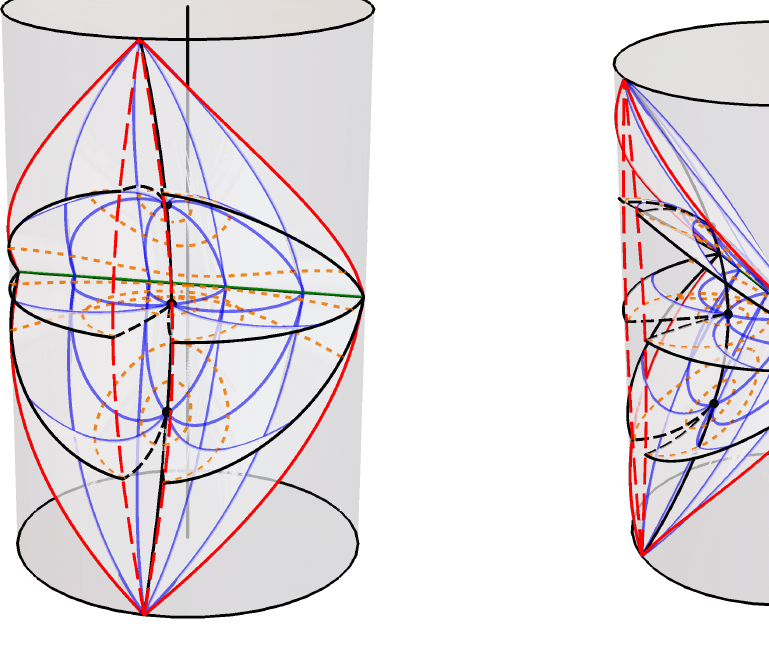
Figure 7 . The Class I rapid,A solution embedded within global AdS 3 . The particle worldline is shown in solid black. Several surfaces of constant t are plotted. The event horizons are demonstrated by the surfaces at early and late t . The bifurcation surface is shown as a green line. A “wedge” is removed, with its edges x = x + and x 0 = x + identified; this is the location of the domain wall. These edges are shown in long-dashed black within each time-slice, and in dashed red at the boundary. The boundary of the classically accessible subset of the global boundary is shown in red. Lines of constant x are shown in blue, with lines of constant y in dashed orange. To guide the eye, the axis of the cylinder is also shown in